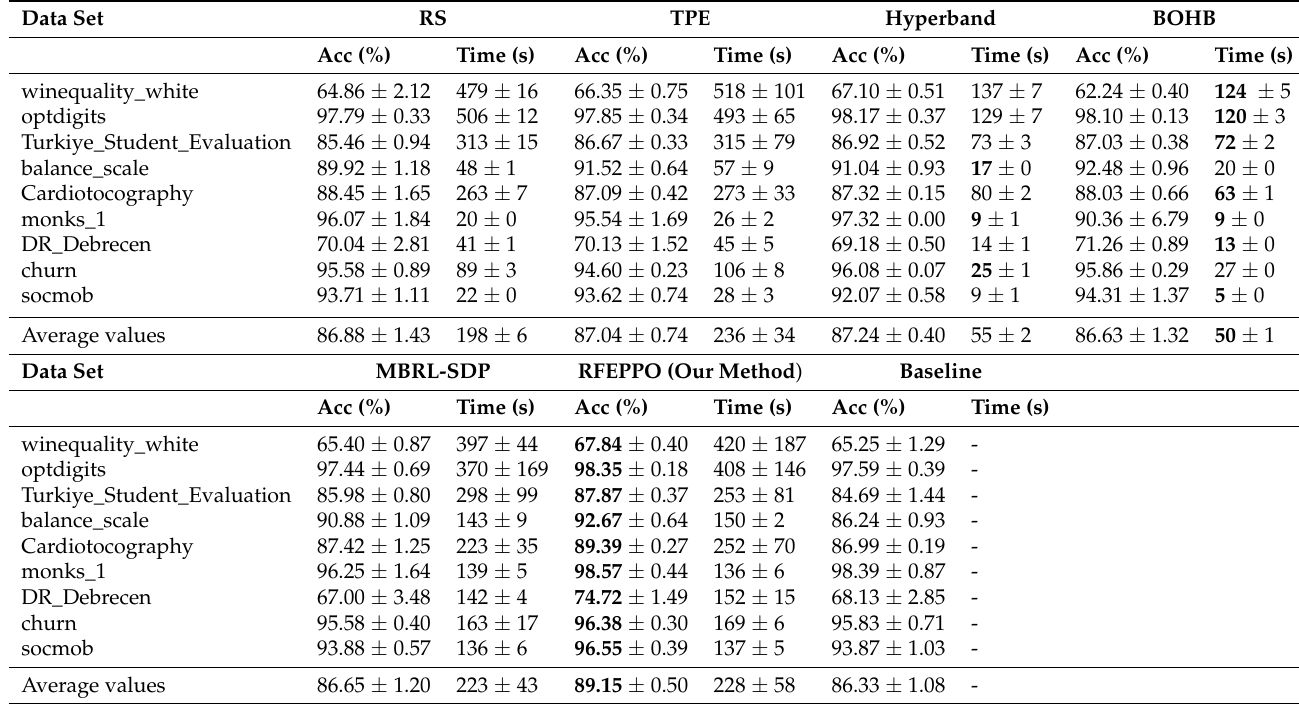
Table 3. The performance (mean ± std) of our method and other conventional algorithms on nine tabular